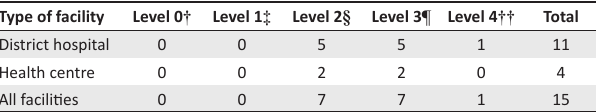
TABLE 2: Readiness of selected health facilities in Lesotho ( N = 15) in 2016 to introduce HIV point-of-care early infant diagnosis based on a standardised